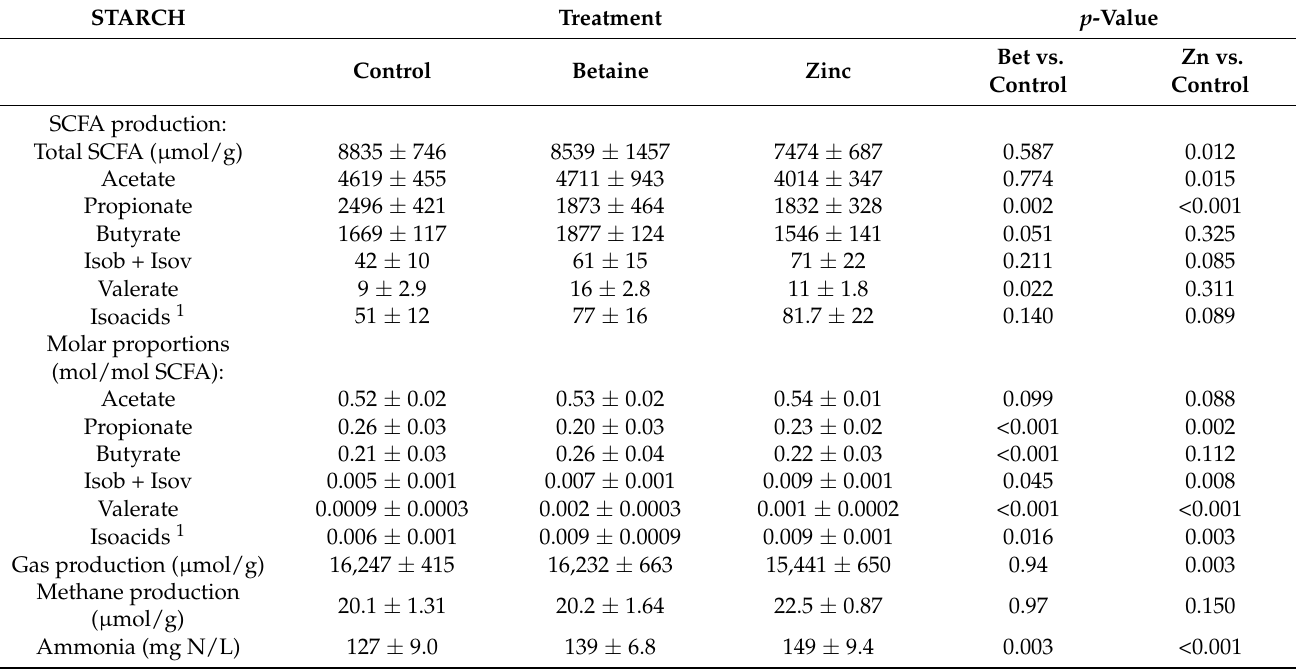
Table 1. Production of SCFA, molar proportions of SCFA, gas and methane production, and ammonia concentration after 24 h of the in vitro fermentation of starch by fecal inocula obtained from pigs under heat stress conditions and fed diets supplemented or not with betaine (5 g/kg) or zinc (0.120 g/kg). Means ± standard deviations are shown.